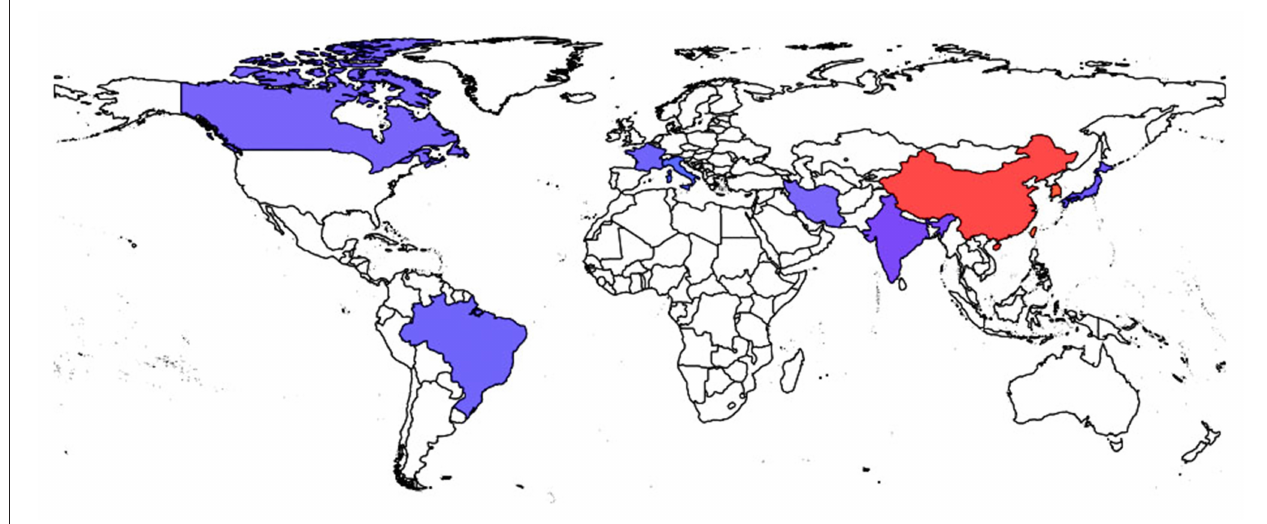
FIGURE 3 | Worldwide spread of CR-hvKP strains. Endemic spread of CR-hvKP strains were reported from the countries indicated in red while the blue colored regions represent the sporadic occurrence of CR-hvKP strains.